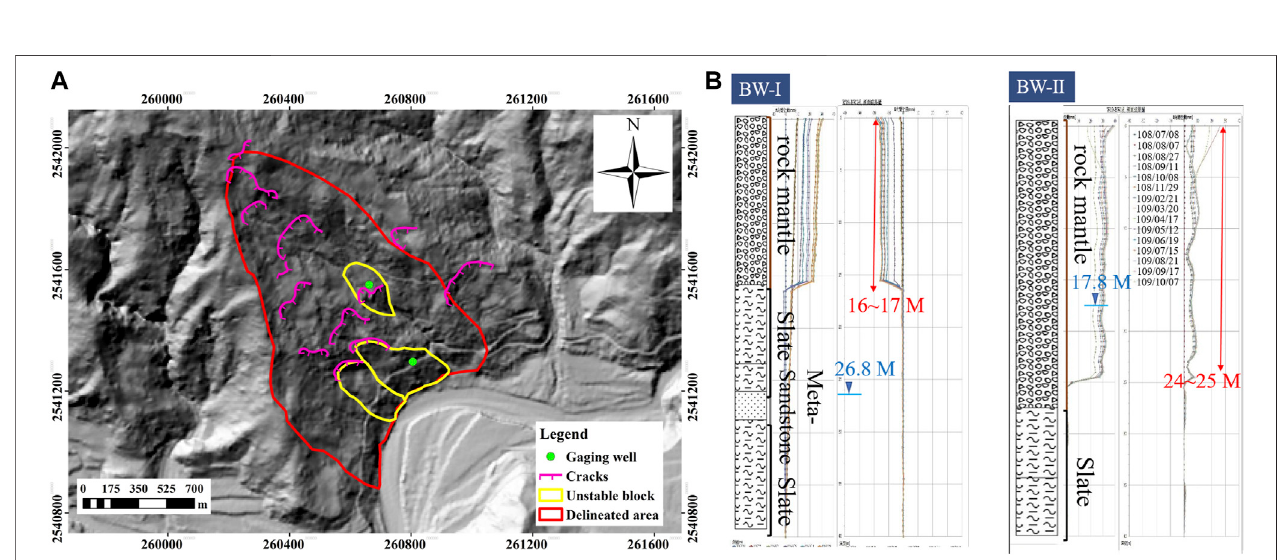
FIGURE 6 | (A) The hillshade map of Taitung-Yanping-T003, where the red line outlines the suspected landslide-prone area, the yellow lines indicate three blocks plausiblyinmovement,thecracksaredepictedbyredcurveswithbulges,andthelight-yellowrailingareasrepresentthedipslopes. (B) Themonitoringrecordsofgaging wells BW-I and